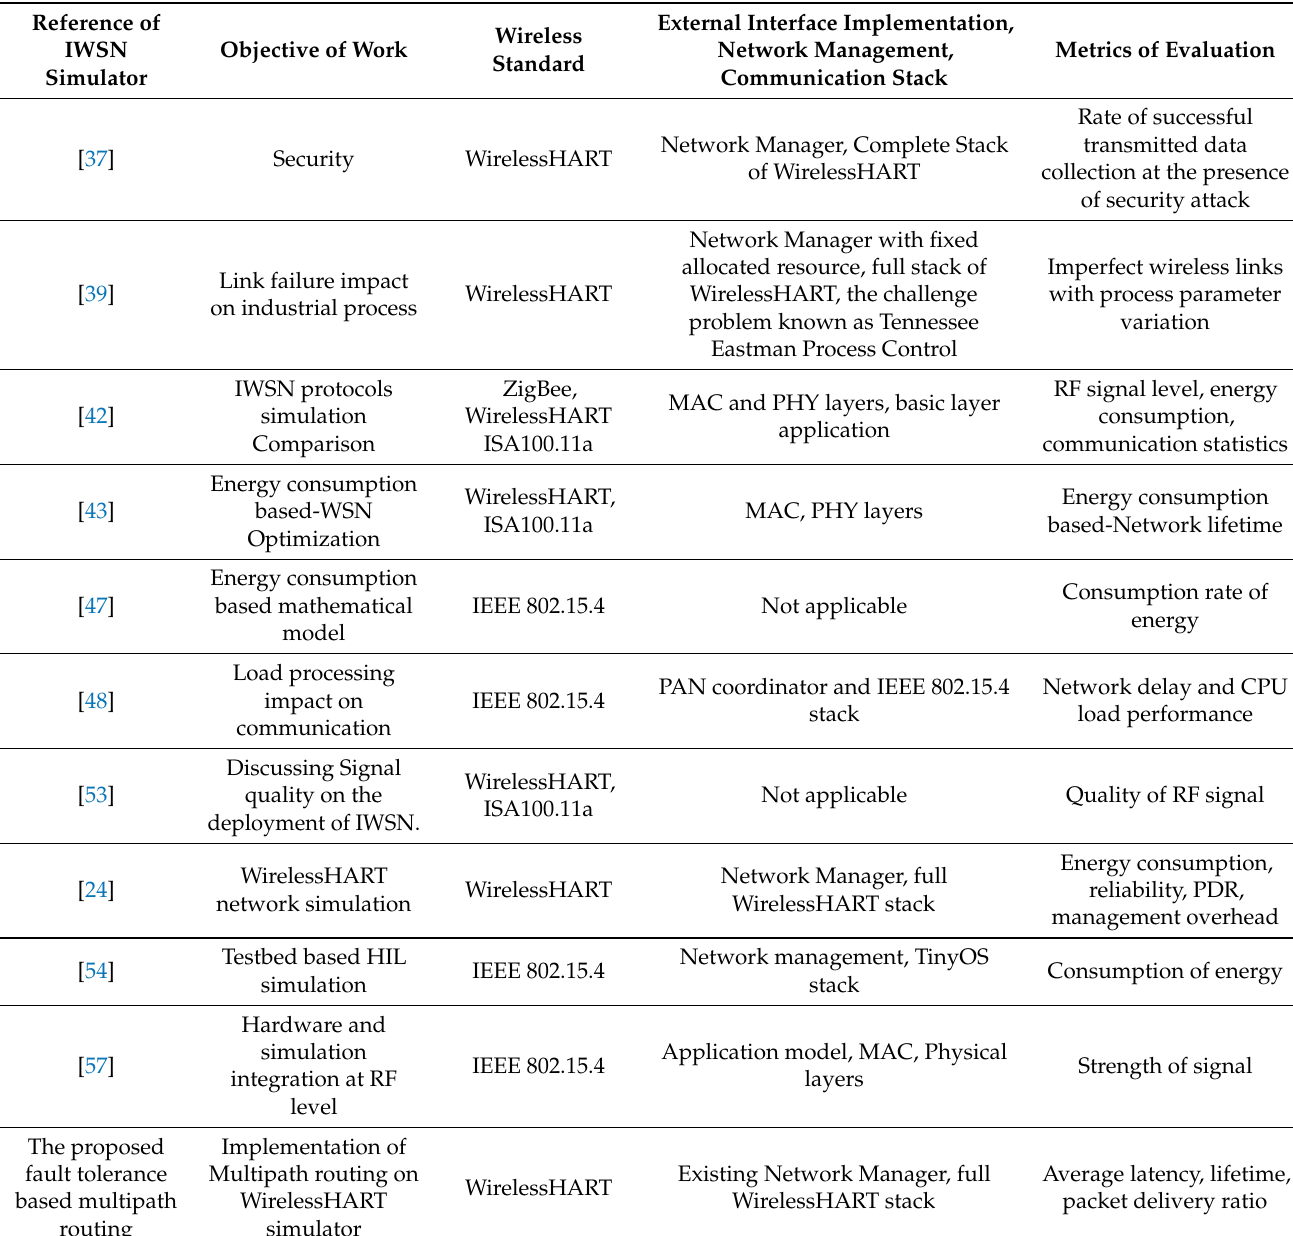
Table 1. Existing IWSN simulation